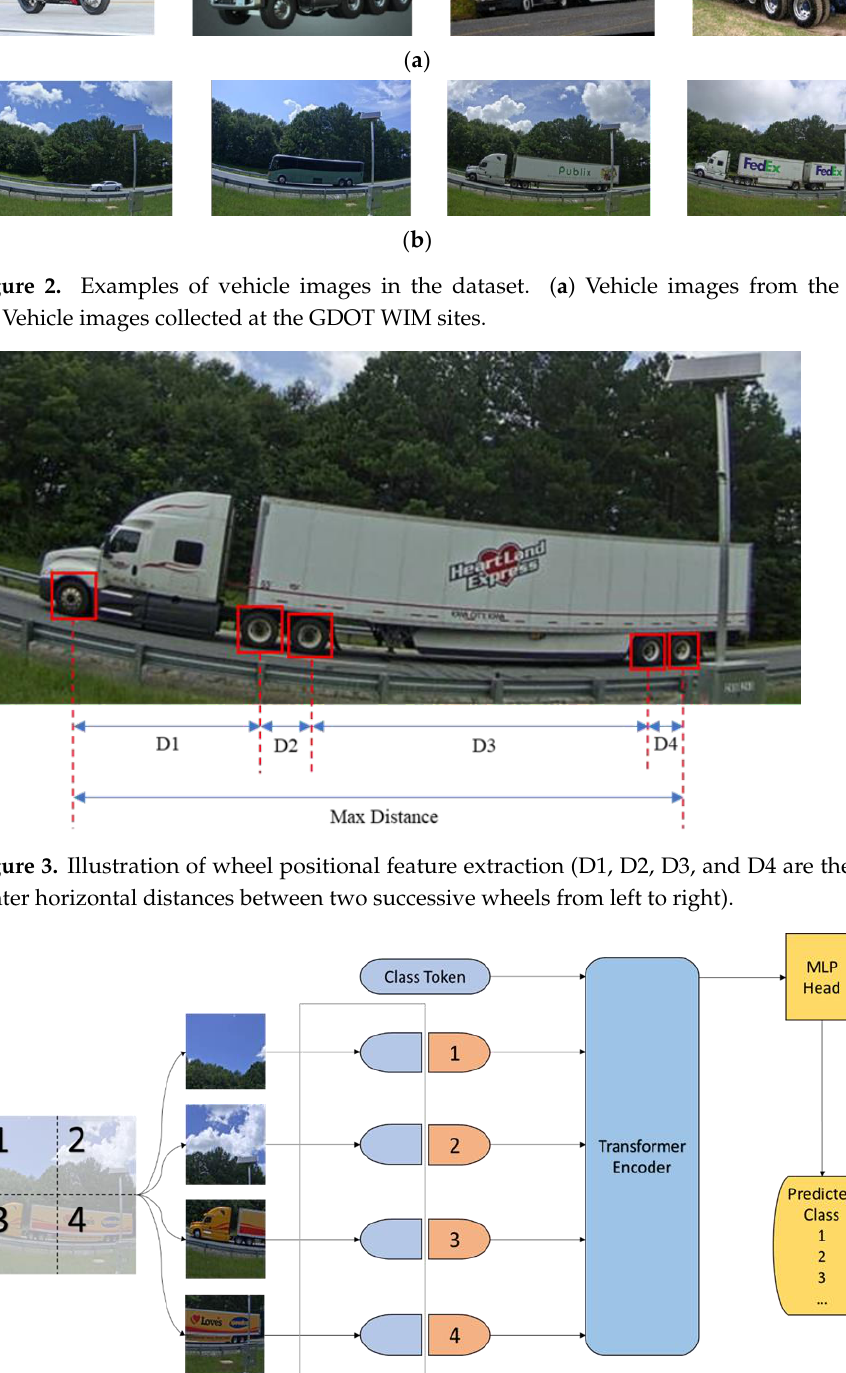
Figure 3. Illustration of wheel positional feature extraction (D1, D2, D3, and D4 are the center-to-center horizontal distances between two successive wheels from left to right). Figure 4. Illustration of a vision transformer. Figure 4. Illustration of a vision